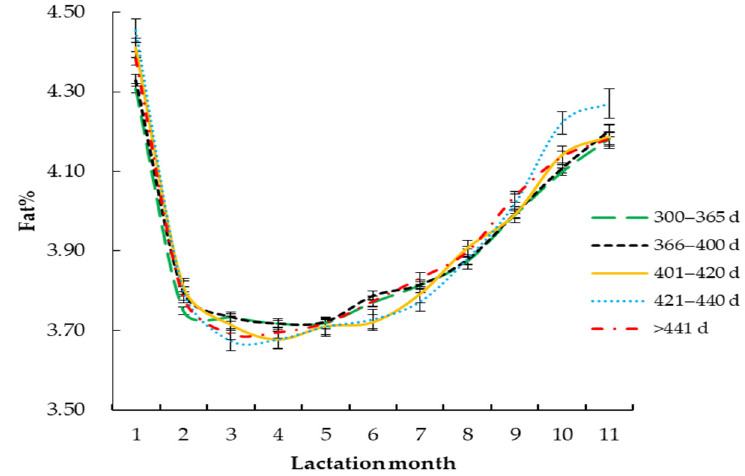
Figure 4. Lactation curves of Wood model for different calving intervals.